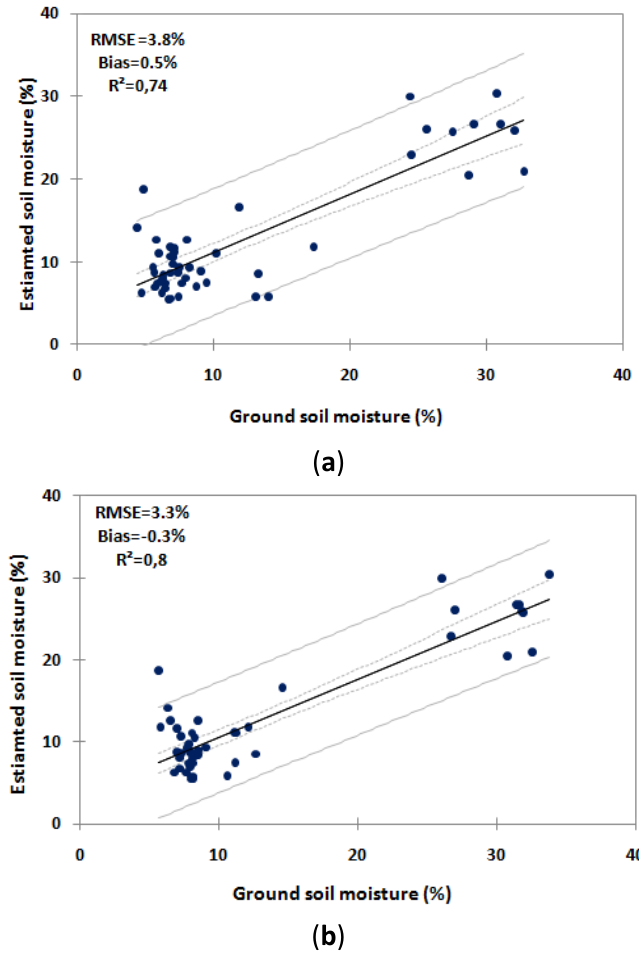
Figure 5. Validation of the two proposed change detection approaches over 15 test fields (each point corresponds to one moisture condition in one test field): ( a ) assuming no change in roughness; ( b ) taking roughness changes into account.